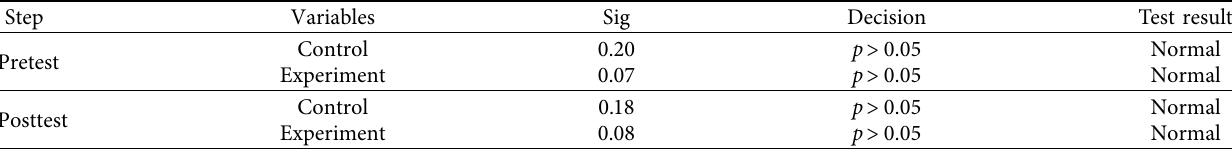
Table 19: Test table for normality of variables in the pretest and posttest (the advanced group for writing).